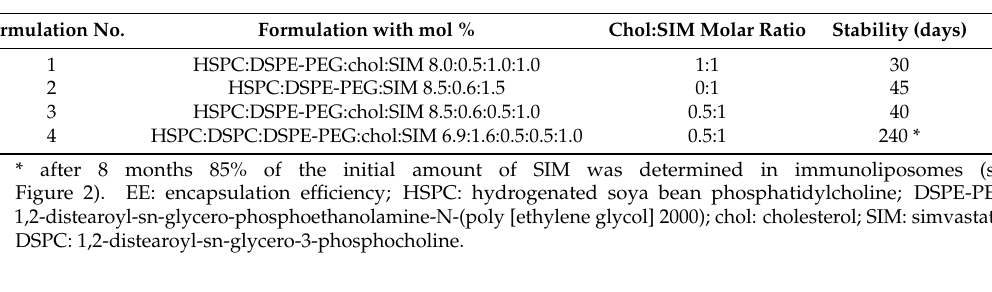
Table 1. Studied liposomal